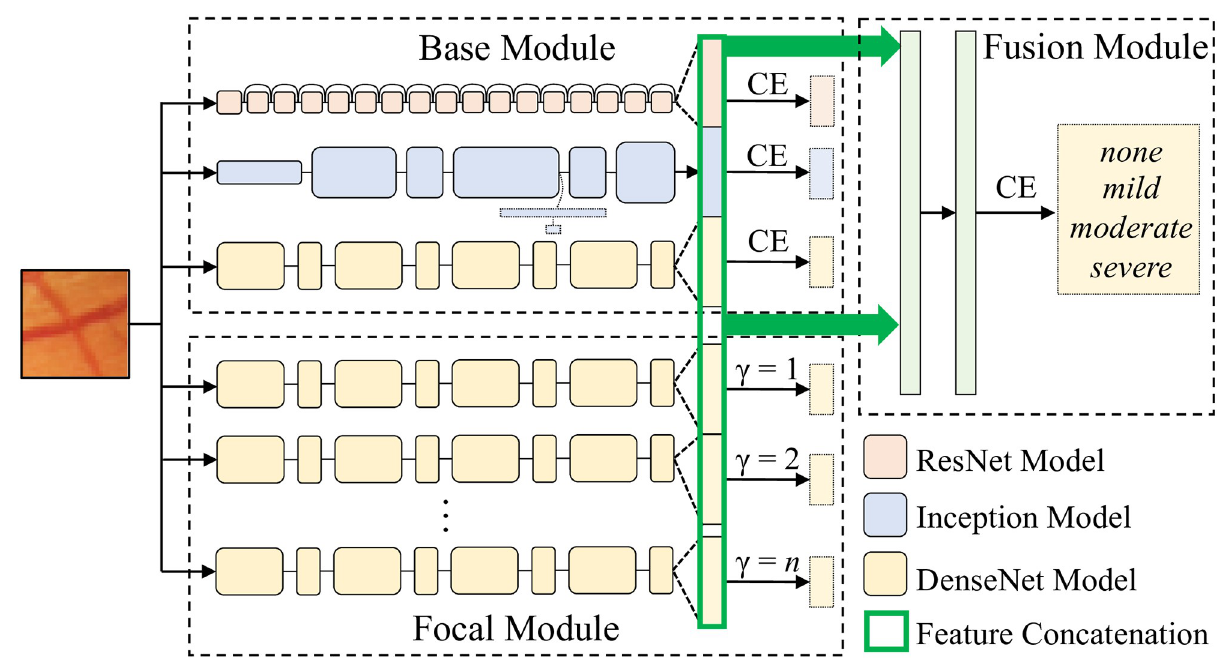
Fig 3. MDTNet for severity grade